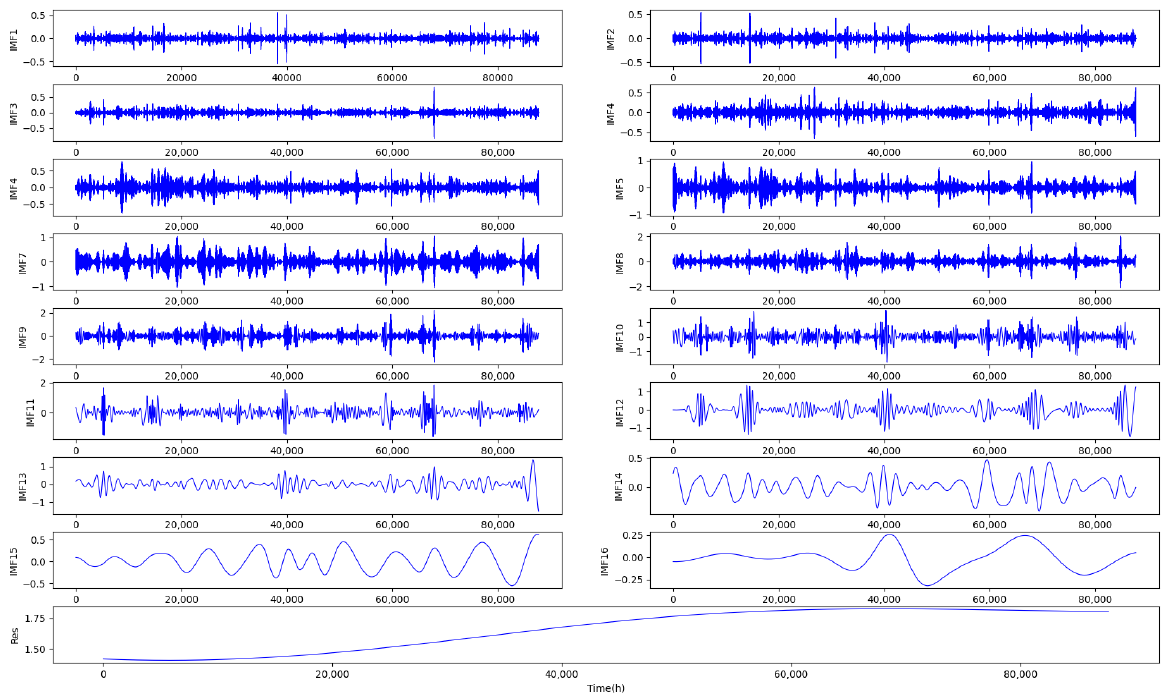
Figure 11. The EMD method was used to decompose the significant wave height results at position D.